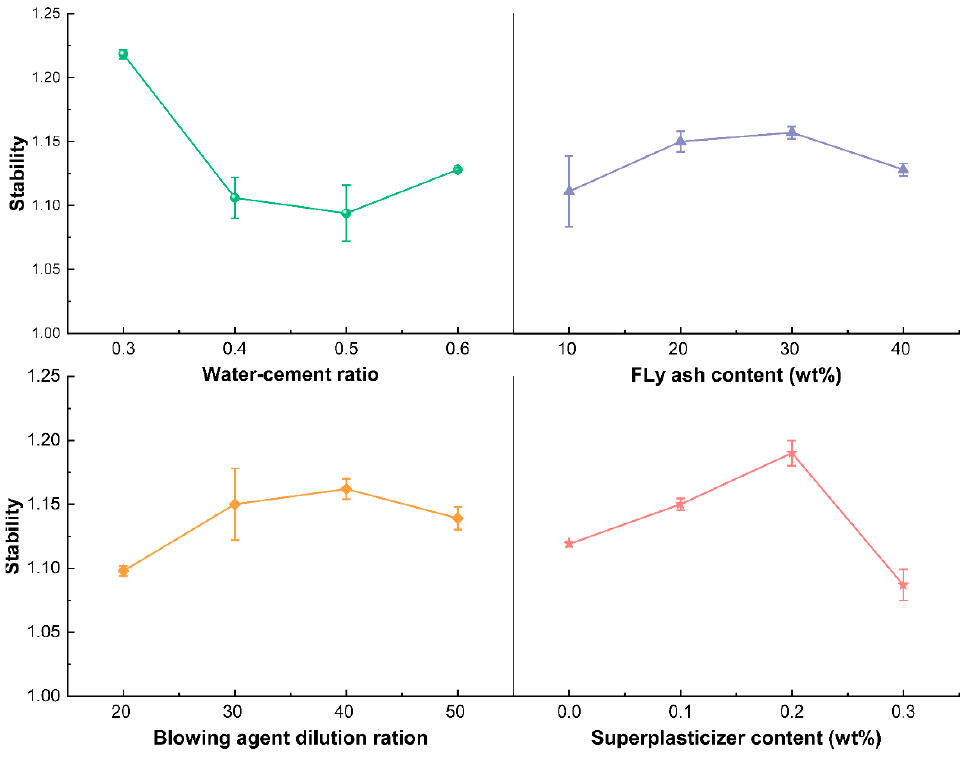
Figure 6. Effects of various factors on the stability of foam concrete.